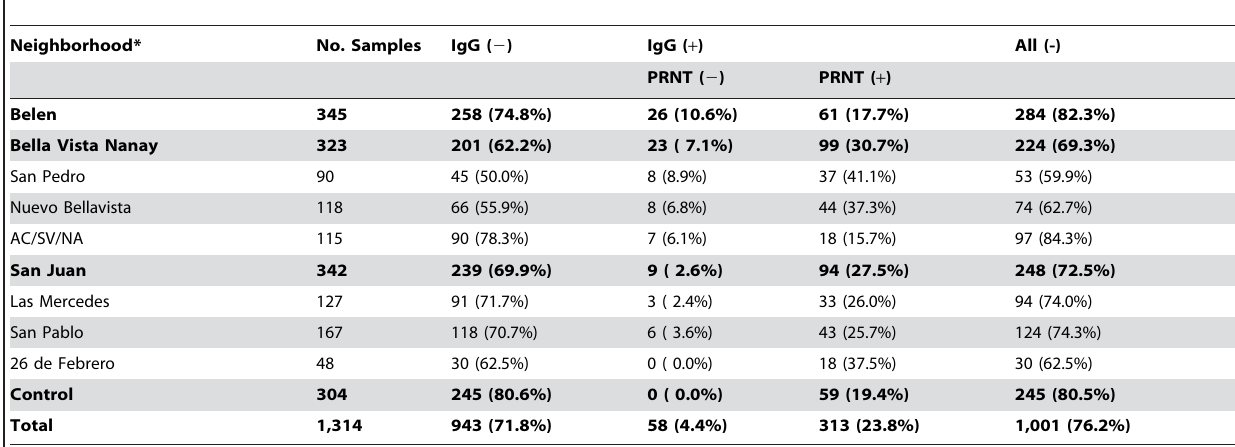
Table 4. Prevalence of anti-VEEV antibodies among 1,314 subjects living in 4 neighborhoods in Iquitos, Peru.